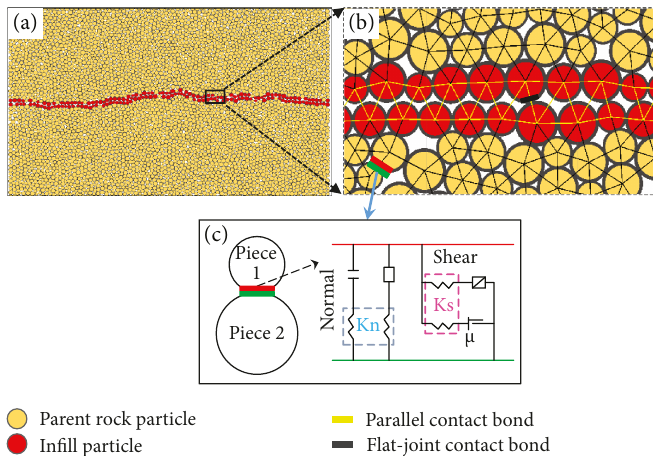
Figure 2: In fi lled joint and contact models. (a) Numerically simulated specimen with an in fi lled joint. The yellow and red particles represent the intact rock and in fi ll, respectively. (b) Magni fi ed picture of Figure 2(a). (c) Components of the linear parallel contact bond